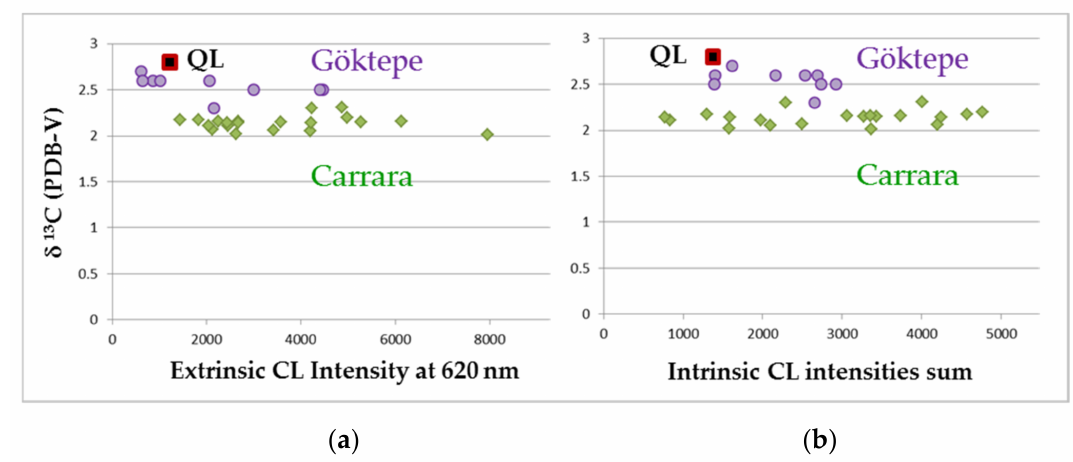
Figure 8. Isotopic δ 13 C vs. CL intensities of the archaeological sample QL (red and black square) along with data from Göktepe and Carrara (Fantiscritti) quarries, according to [24]. ( a ) scatterplot of the extrinsic CL; ( b ) scatterplot of the UV